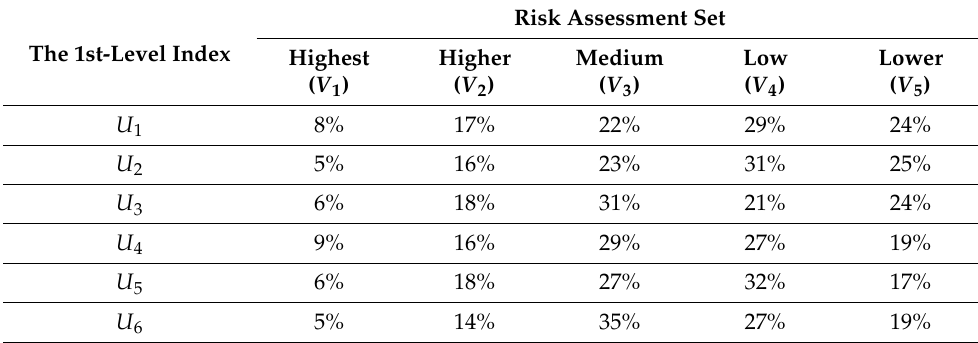
Table 3. Statistical result for major risk evaluation of